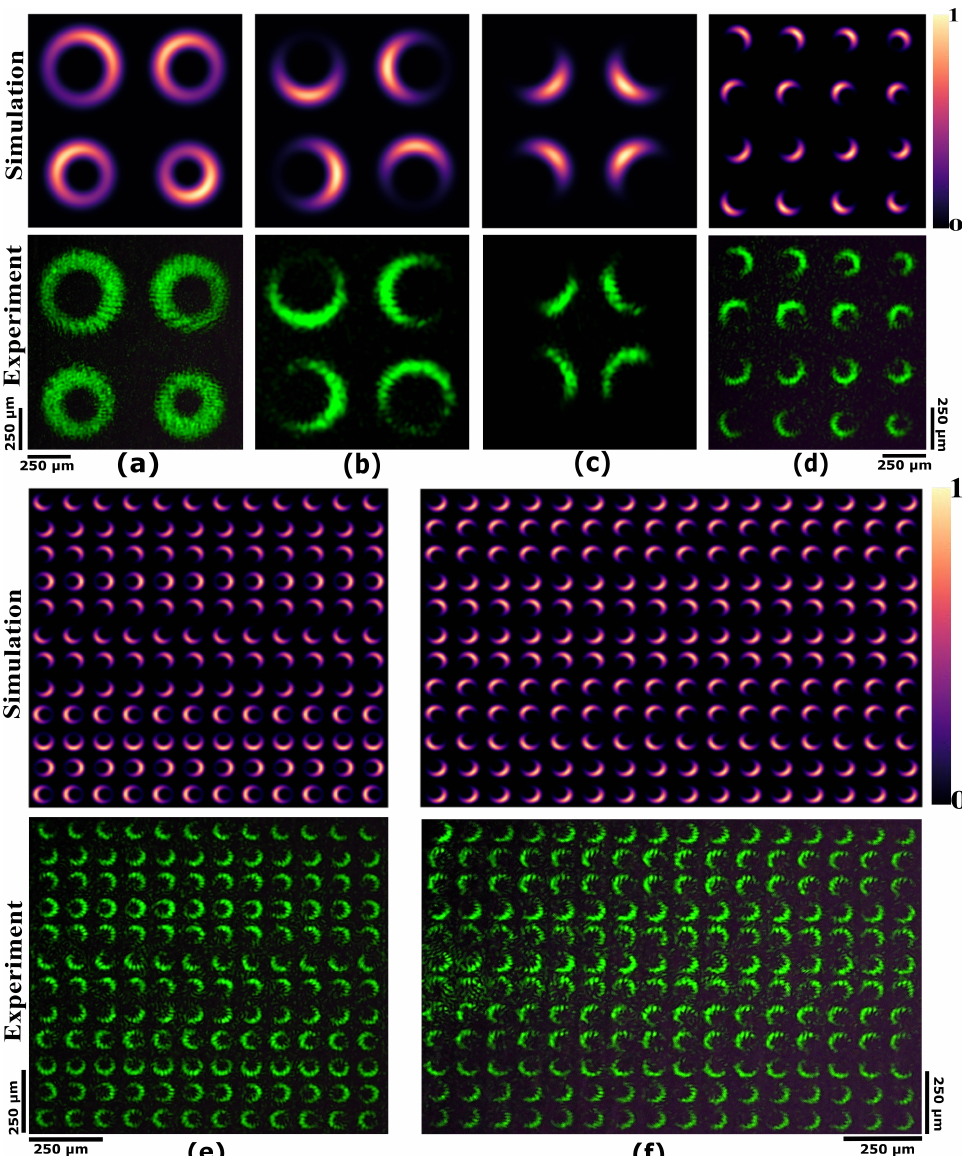
Figure 7. Simulation and experimental intensity profile of asymmetric LG beam array with different asymmetricity and array dimensions ( a ) 2 × 2 with radial index = 0 and azimuthal index = 3, 4, 5 and 6, ( b ) 2 × 2 with radial index = 0 and azimuthal index = 5, ( c ) 2 × 2 with radial index = 0 and azimuthal index = 5, ( d ) 4 × 4 with radial index = 0 and azimuthal index = 3, 4, 5 and 6, ( e ) 12 × 12 with radial index = 0 and azimuthal index = 5, and ( f ) 12 × 16 with radial index = 0 and azimuthal index =